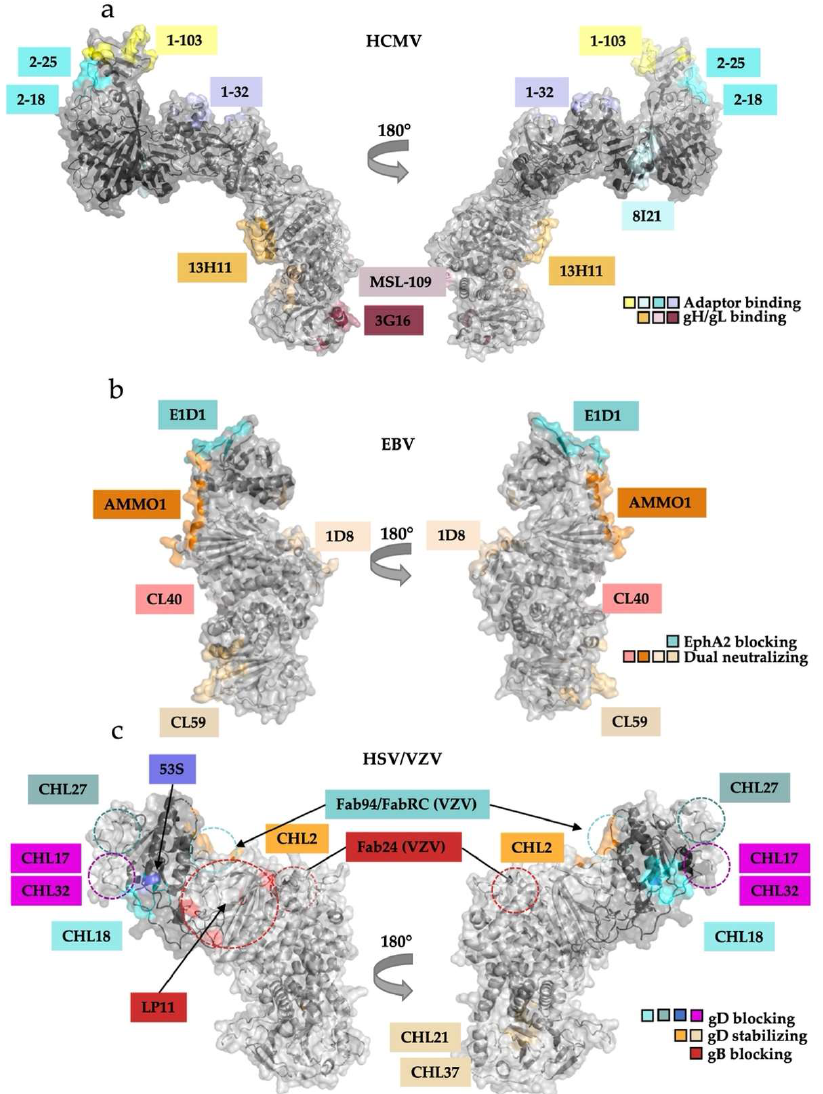
Figure 5. Antibody binding locations on the gH/gL suggest their mechanisms of action. ( a ) Antibodies against HCMV pentamer bind either the gH/gL heterodimer or the adaptor subcomplex. 13H11, MSL-109, and 3G16 neutralize infection of both fibroblasts and epithelial cells whereas the pentamer-binding neutralizing Abs only prevent infection of epithelial or endothelial cells. ( b ) EBV-neutralizing Abs interfere with EphA2 binding but not gp42 or HLA-II binding. E1D1 prevents infection of epithelial cells by sterically interfering with EphA2 engagement by gL. AMMO1, CL40, and CL59 block infection of both epithelial and B-cells without interrupting receptor engagement. ( c ) A battery of antibodies and antibody fragments (Fabs) that bind gH/gL exert different effects on HSV entry. They can be grouped according to their effects: blocking gD binding, stabilizing gD binding, or blocking gB binding. The effects are localized to specific regions of gH/gL. The existing structure of HSV-2 gH/gL is missing the first 29 amino acids of gH after the signal sequence; the approximate locations of the epitopes that map to this region (CHL27, CHL17, CHL32) are indicated schematically with dashed circles. Approximate locations of the LP11 epitope and the epitopes of three Fabs that bind VZV gH/gL are indicated schematically on the HSV-2 gH/gL structure with dashed